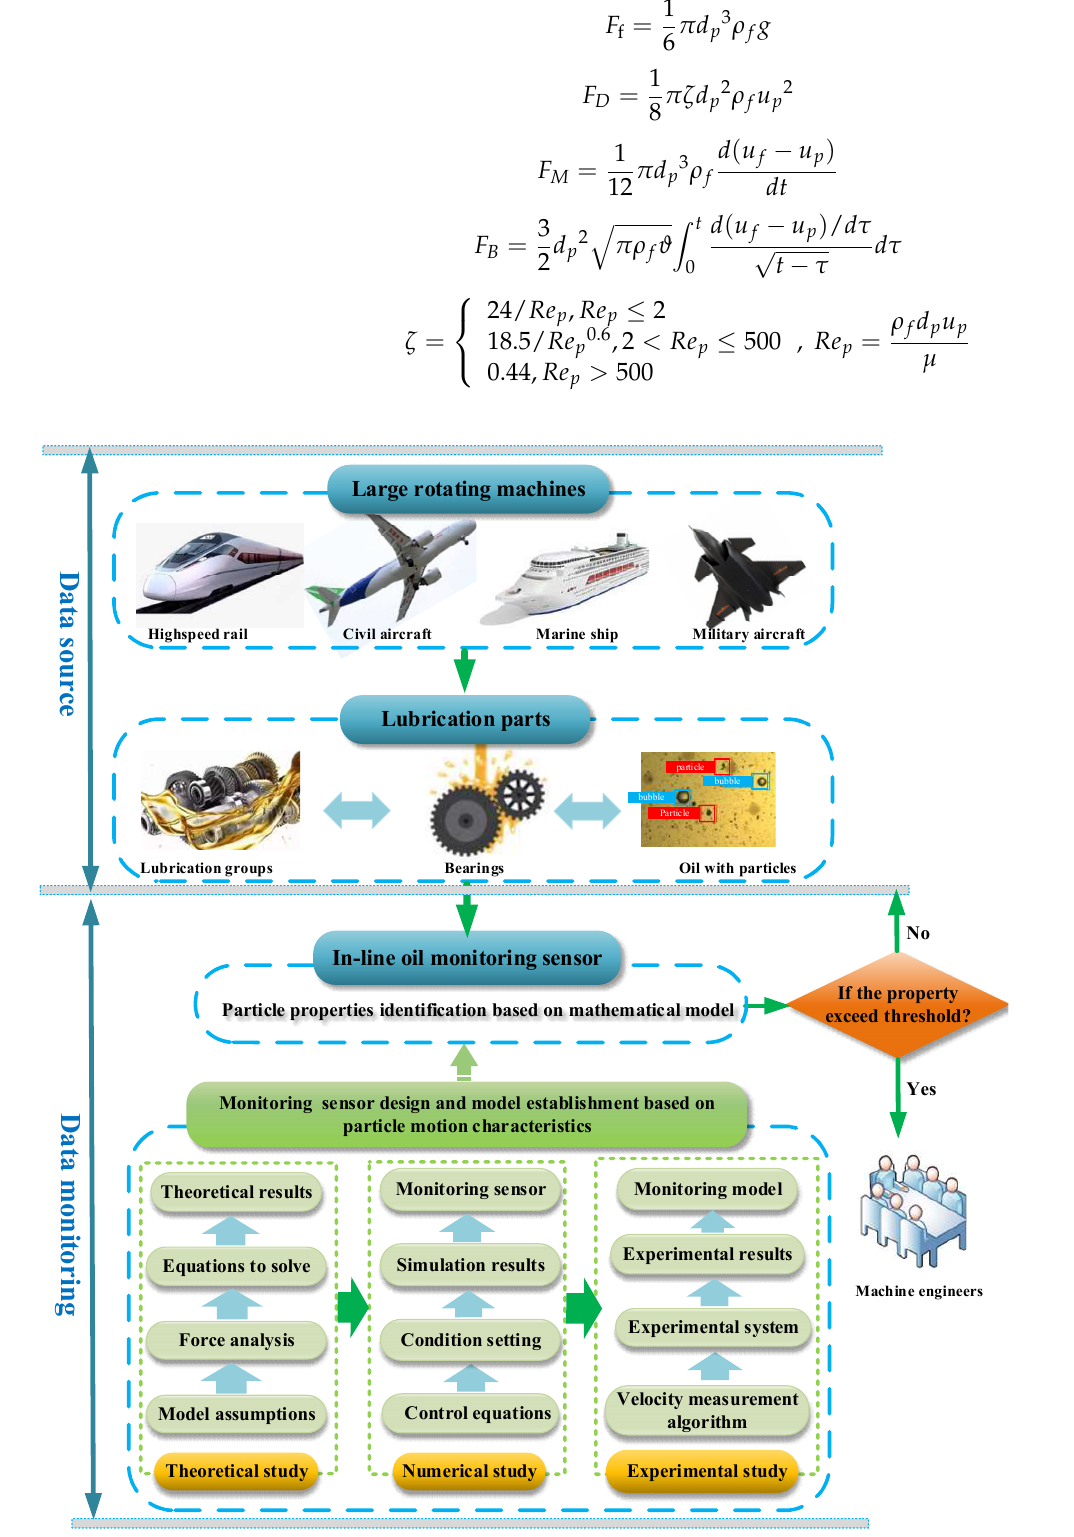
Figure 1. The proposed framework for analysis of the motion of wear particles.